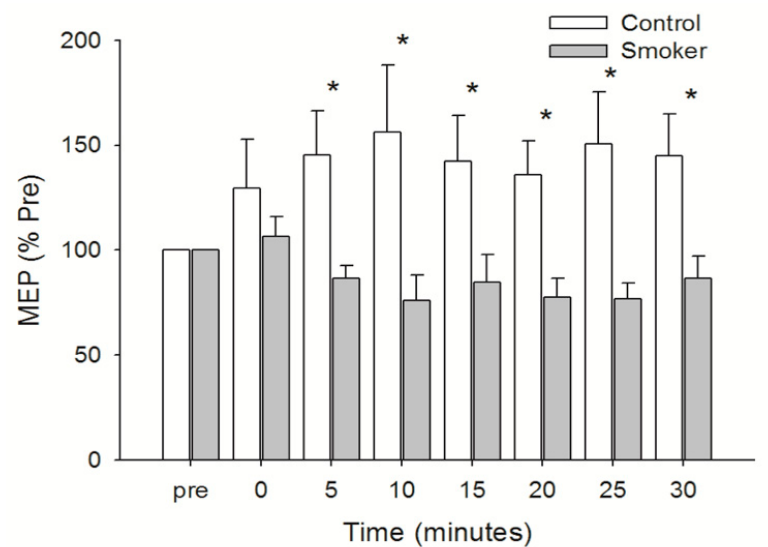
Figure 3. Peak-to-peak MEP for the Smoker and Control groups across time. This figure shows mean values ± standard error of the mean (SEM) of data normalized to the pre-exercise value. A two factor mixed-design analysis of variance (ANOVA) was performed and indicated a difference between groups. The differences were located using a Fischers PLSD post-hoc analysis and * indicates difference between groups at each time point after PAS.